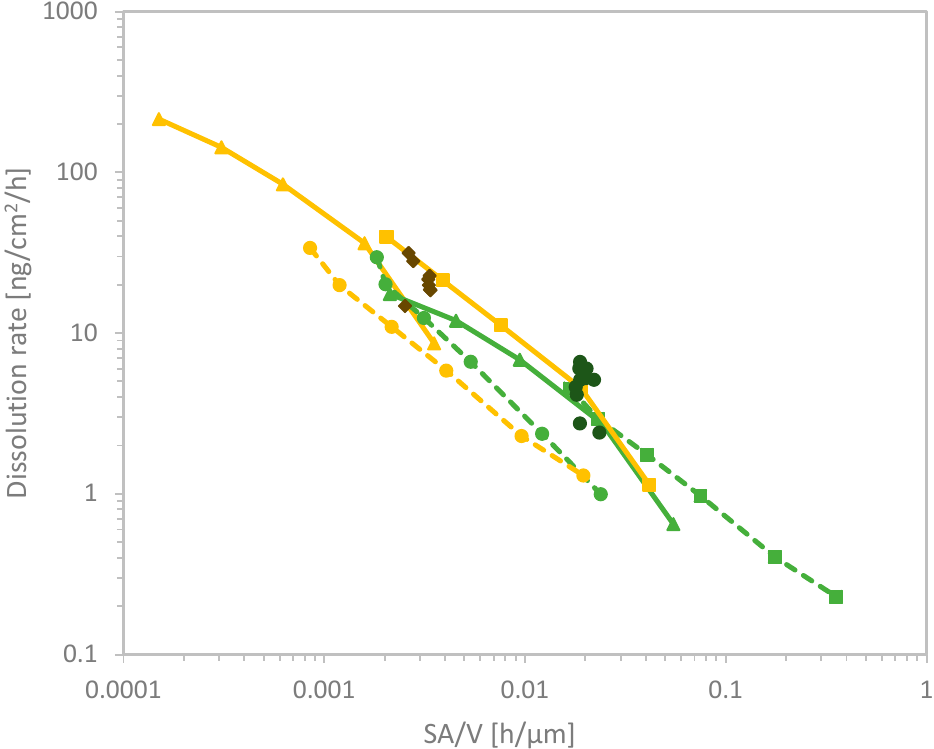
Figure 4. Dissolution rate of BaSO 4 NM220 (green) and BaSO 4 IRMM381 (yellow). The SA/V is plotted against the dissolution rate k [ng/cm²/h]. The dashed line indicates the ramp down with decreasing flow-rate 3–0.1 mL/h and the solid line represents the ramp up with increasing flow-rate from 0.1 to 3 mL/h. The two different dashed green curves vary in initial mass. The dashed green curve with the square has an initial mass of 1.01 mg, whereas the curve with the round symbol has an initial mass of 0.14 mg. The two yellow solid curves vary from 1.42 mg initial mass for the square to 0.12 mg for the triangle. Both darker spots represent the dissolution rate for the dynamic dissolution with constant flow-rate for nano BaSO 4 NM220 yellow and BaSO 4 IRMM381 dark green. The consistency between the instantaneous dissolution rates determined with fixed flow vs.